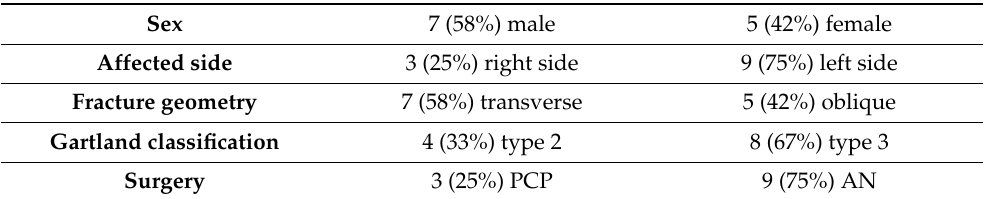
Table 2. The study population of 12 patients with postoperative malrotation who underwent a follow-up examination. Sex 7 (58%) male 5 (42%) female Affected side 3 (25%) right side Fracture geometry 7 (58%) transverse Gartland classification Surgery